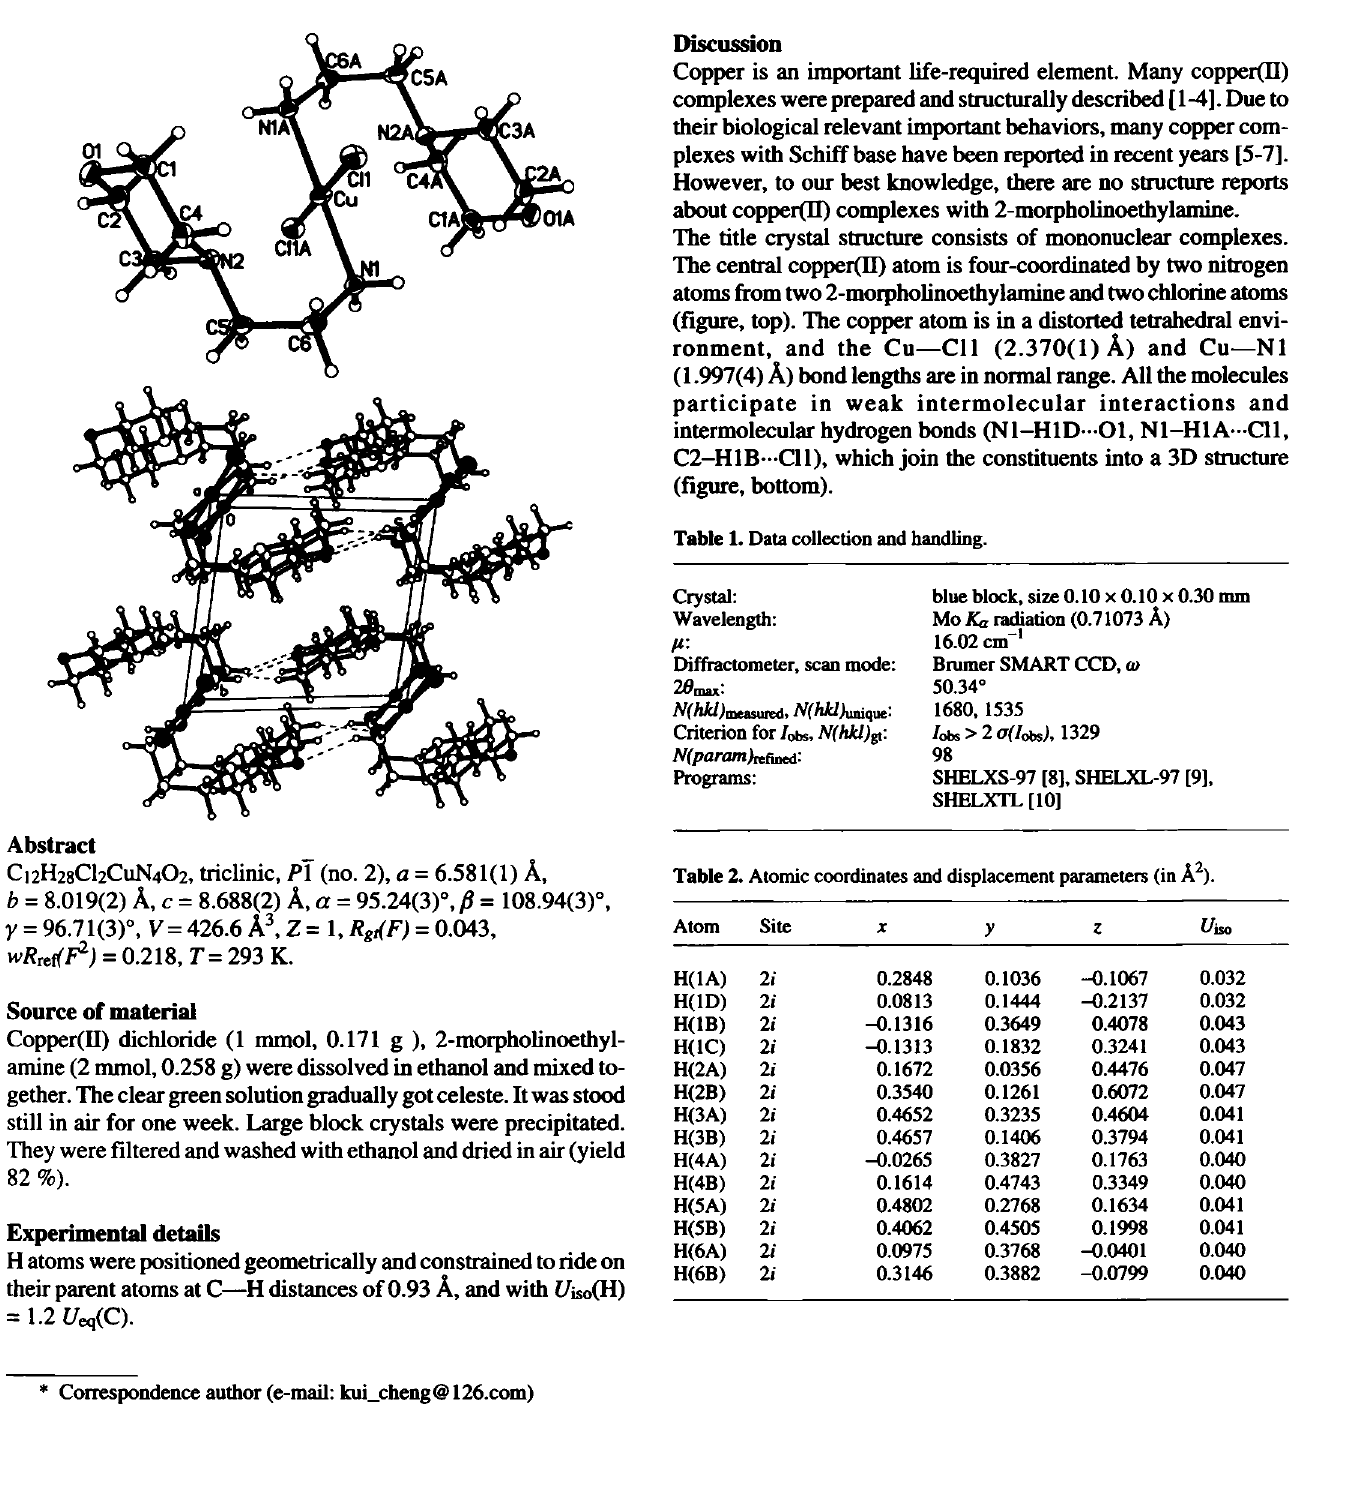
Table 1. Data collection and handling.